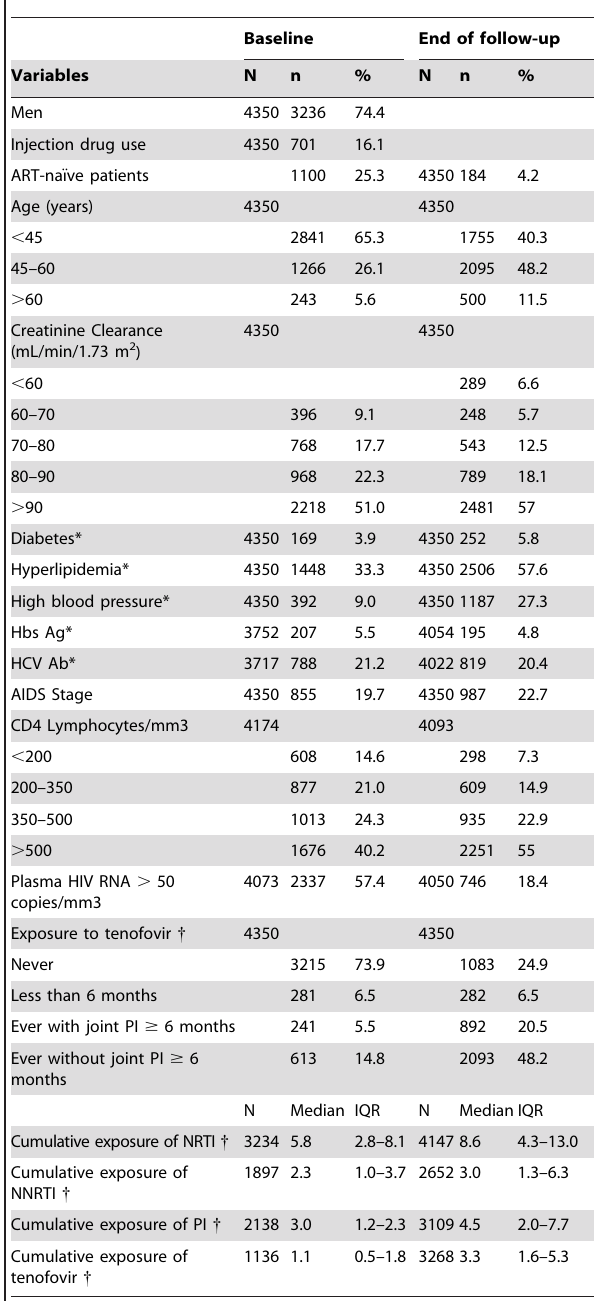
Table 1. Patient’s characteristics at baseline and at end of follow-up, Aquitaine Cohort 2004–2012,